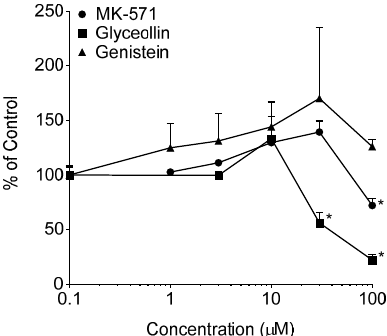
Figure 4. CDF uptake into Caco-2 cells. Net CDF fluorescence normalized to cell protein Figure 3. Hydrolysis of CDFDA by Caco-2 Cells. CDF concentration as a function of time was measured following a 30-min incubation with 5 µM CDFDA in the presence of varying following incubation with 5 µM CDFDA for up to 4 h in the absence (control, dashed line) concentrations of MK-571, glyceollin or genistein ranging from 0 µM (control, arbitrarily or presence of 100 µM of MK-571, glyceollin or genistein. N = 3 for each condition. Specific represented as 0.1 µM on the log-scale) to 100 µM. Results represent the mean + SEM of activities based on initial rate conditions were 6.0, 6.2, 8.5 and 32.7 nM/min/mg protein for two (glyceollin and genistein) or four (MK-571) separate experiments, with N = 4 for each control, glyceollin, MK-571 and genistein, respectively. concentration per experiment. * indicates significantly different from the respective compound control ( p < 0.05) from a one-way ANOVA followed by Tukey’s t -test.